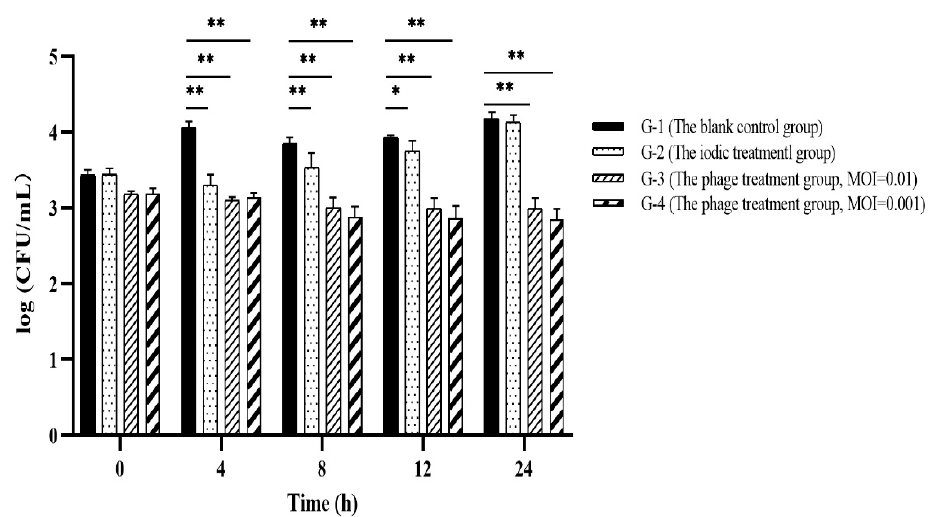
Figure 11. Application evaluation of PVA23 against Vibrio in commercial shrimp farming plants. In experiment, it was hard to manage to get identical Vibrio counts in different ponds, the ponds with Vibrio ≥ 1000 CFU/mL were selected for the trials and each trial repeated. Vibrio counting in the chosen ponds were real, though they might be varied among ponds to some extent. *, p < 0.05, **, p < 0.01.